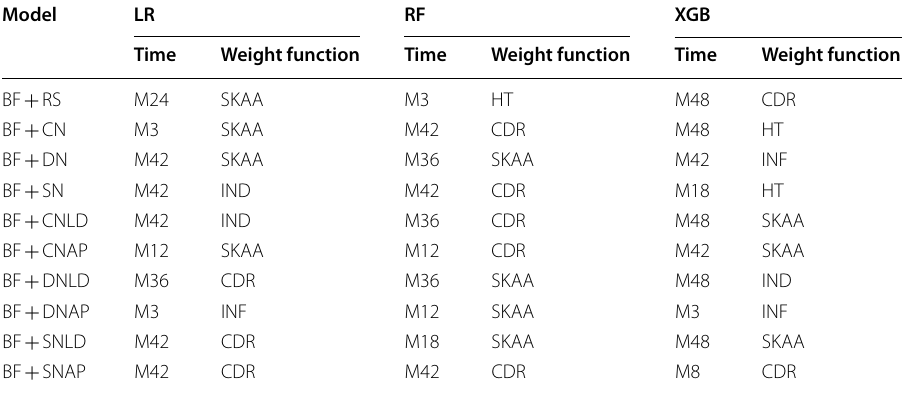
CDR refers to the weight function class-degree ratio, HT refers to the hyperbolic tangent, IND refers to the inverse degree, INF refers to the inverse frequency, and AA refers to the Adamic and Adar Table 20 Optimal hyperparameters of different methods on NEEQ SMEs dataset Model